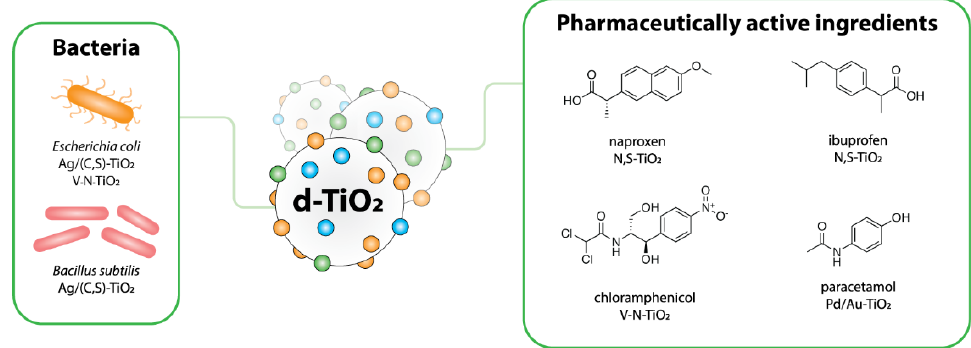
Figure 9. The applicability of multiple atom-doped titania composites as catalysts in the photodeg- radation studies of chemical and pharmaceutical pollutants and bacteria; d-TiO 2 —doped tita- nium(IV)